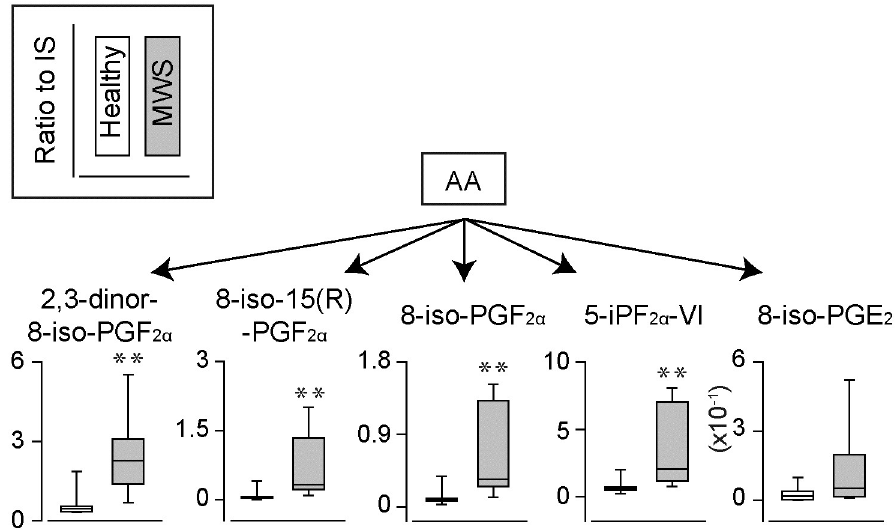
Fig 3. The urinary levels of AA-derived isoprostanes. The urinary levels of arachidonic acid (AA)-derived isoprostanes produced by non-enzymatic oxidation in healthy marmoset (N = 7) and marmosets with MWS (N = 7). �� p < 0.01 compared to healthy